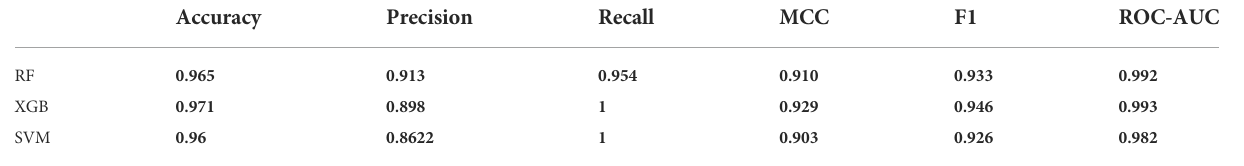
TABLE 3 The performance parameter collation for the Ramdom forest, XGBoost and Support Vector Machine models.